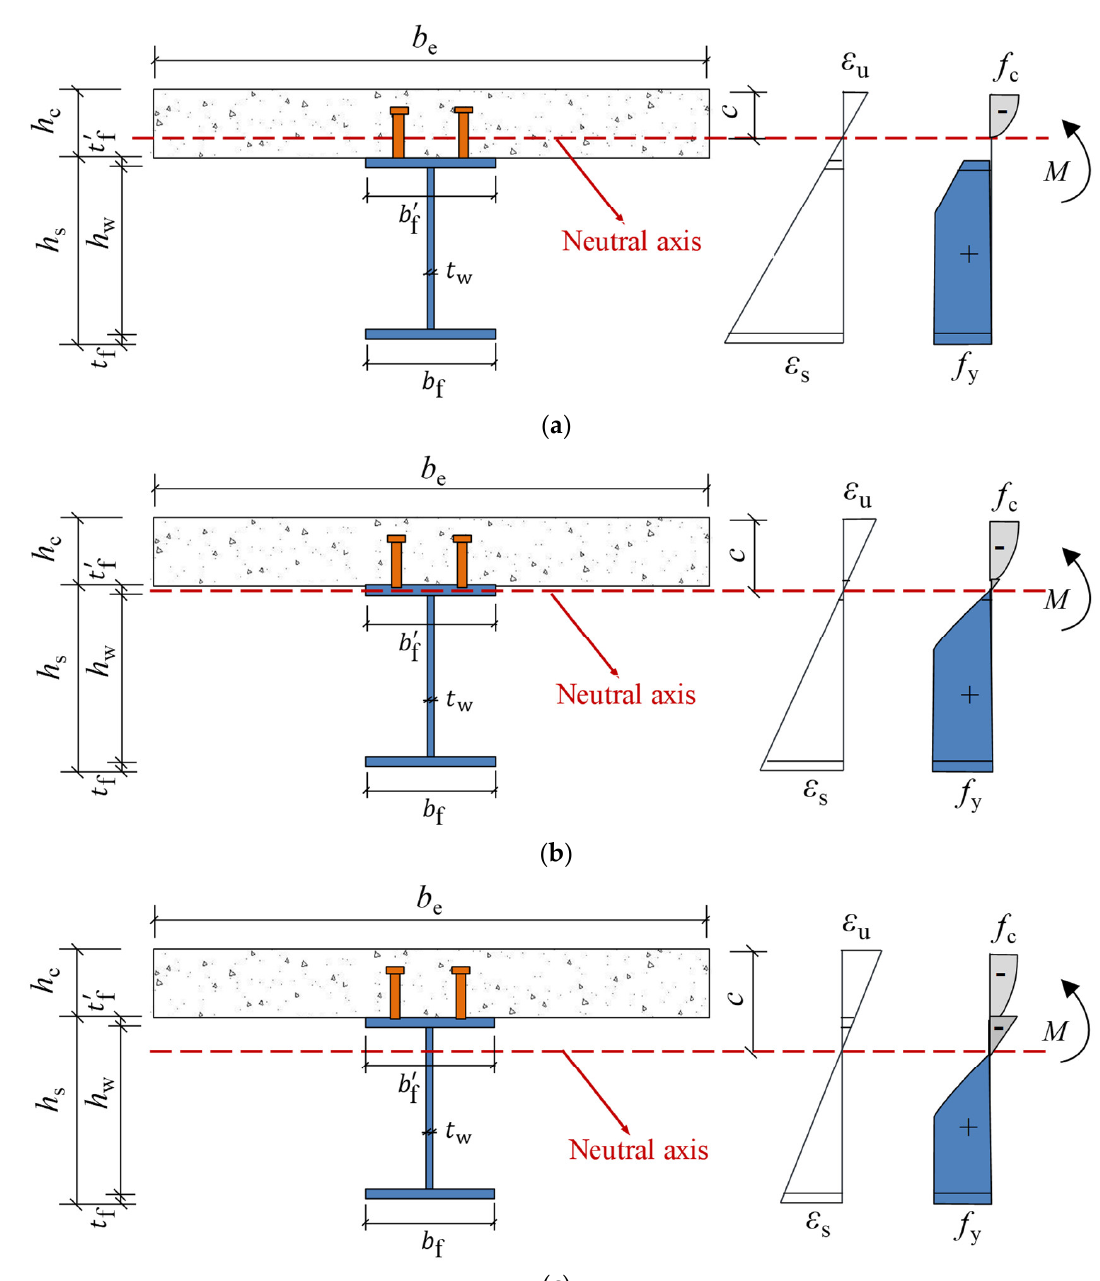
Figure 8. Strain and stress distributions of composite beam section. ( a ) Neutral axis in concrete flange. ( b ) Neutral axis in steel top flange. ( c ) Neutral axis in steel beam web.